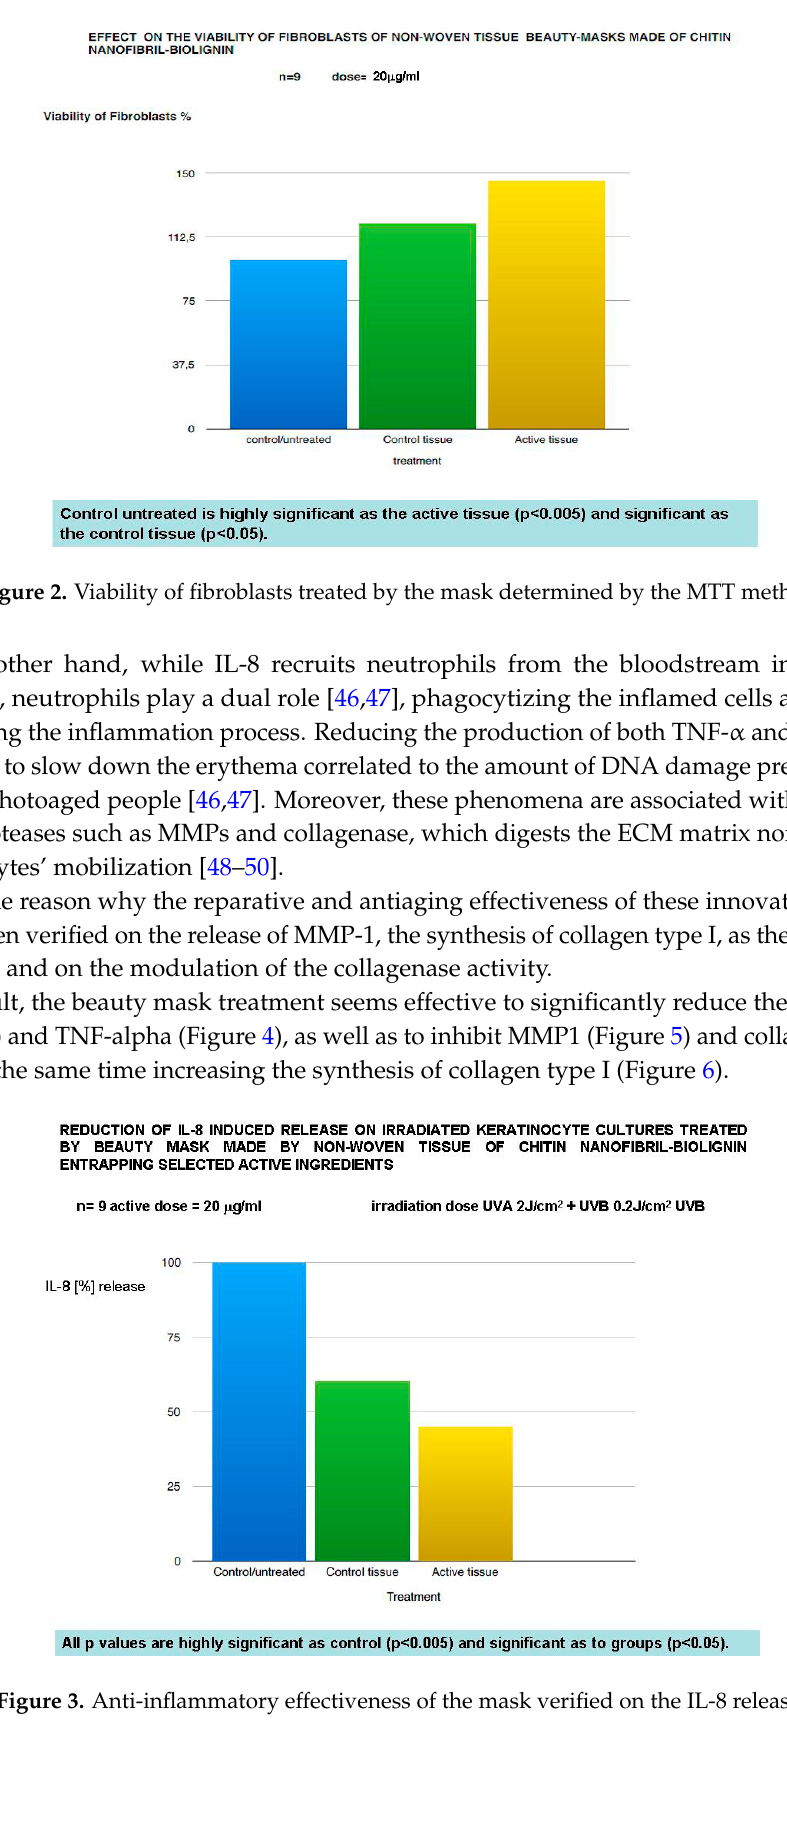
Figure 3. Anti-inflammatory effectiveness of the mask verified on the IL-8 release.